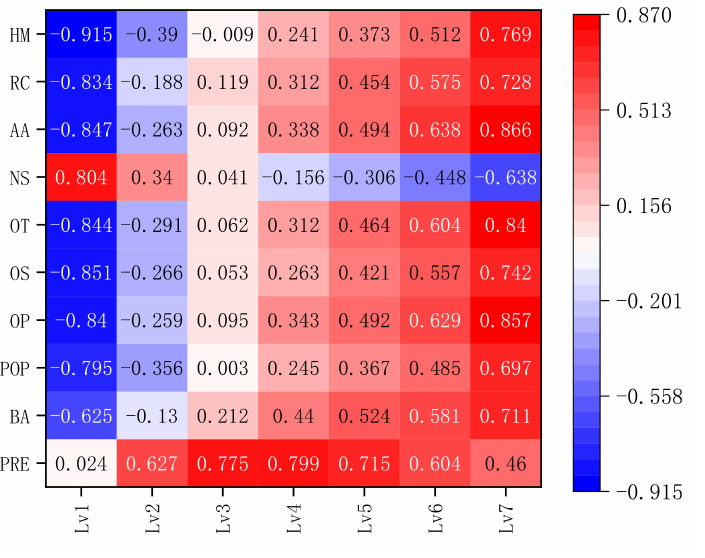
Figure 6. Correlation coefficients between each indicator and the mean value of the NDVI in each area from 2000 to